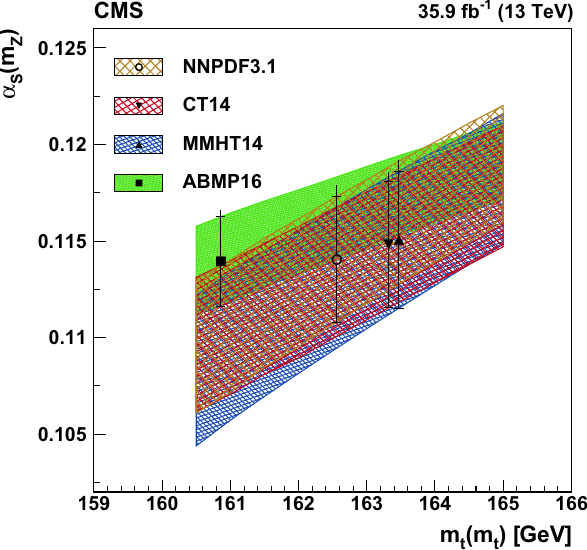
Fig. 13 Values of α S ( m Z ) obtained in the comparison of the σ tt mea- surement to the NNLO prediction using different PDFs, as a function of the m t ( m t ) value used in the theoretical calculation. The results from usingthedifferentPDFsareshownbythebandswithdifferentshadings, with the band width corresponding to the quadratic sum of the experi- mentalandPDFuncertaintiesin α S ( m Z ) .Theresultingmeasuredvalues of α S ( m Z ) are shown by the different style points at the m t ( m t ) values used for each PDF. The inner vertical bars on the points represent the quadratic sum of the experimental and PDF uncertainties in α S ( m Z ) , while the outer vertical bars show the total uncertainties